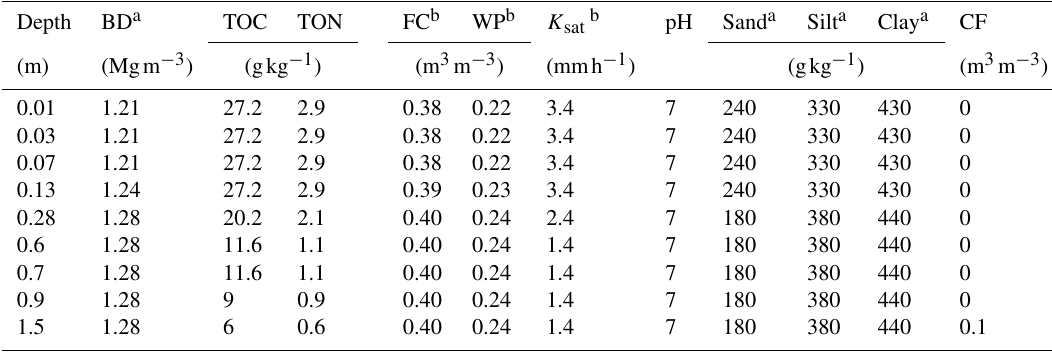
Table 1. Key soil properties of the Eutri-Stagnic Cambisol at Oensingen as used in ecosys . Depth BD a